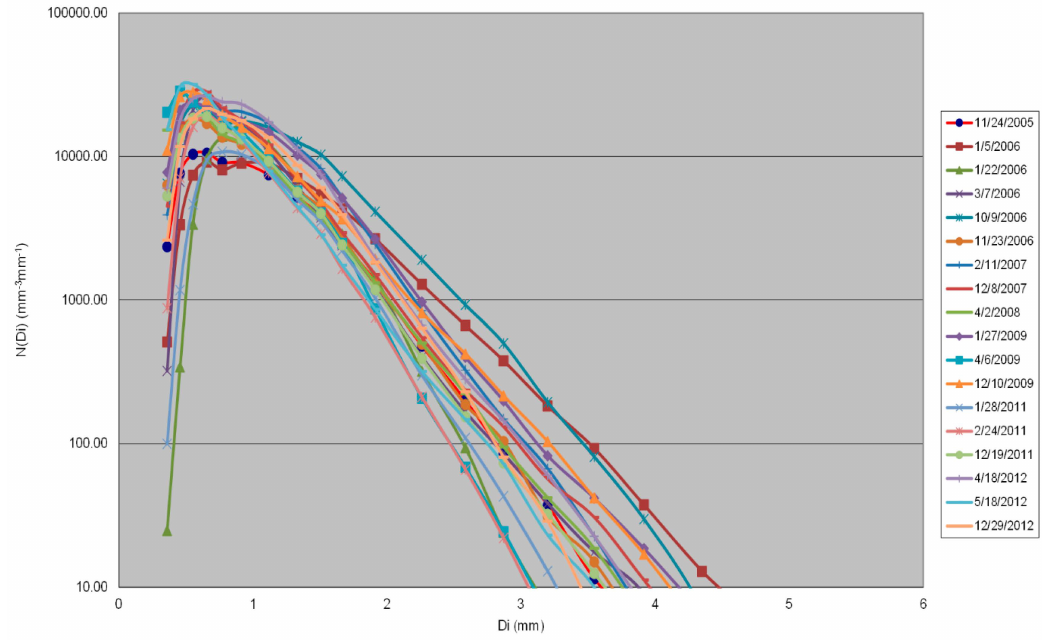
Figure 4. The DSDs of the 18 stratiform events.